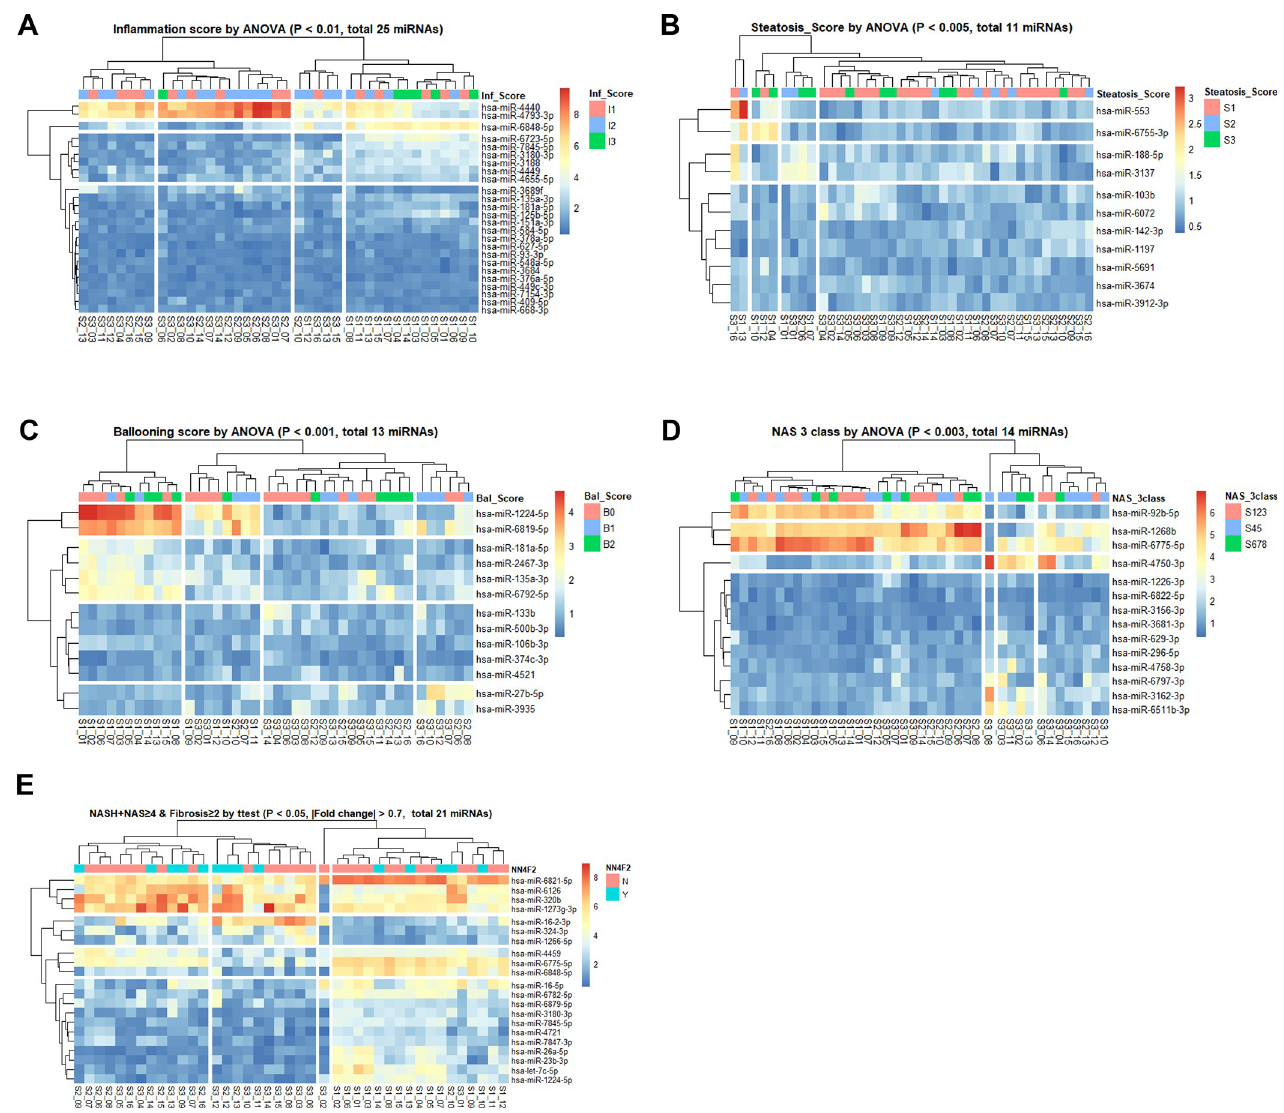
Fig 1. Expression profile heatmaps of five variables. Heatmaps of differentially expressed miRNAs (rows) from 41 patients (columns). At the top of each row, the scoring levels of 2 or 3 for each of the five variables are presented in the bar. Each row indicates identified miRNAs by the t -test or analysis of variance, and each column indicates a patient. Each row and column pair was clustered using the k -means clustering method with the package “pheatmap” in R and divided into four sections.